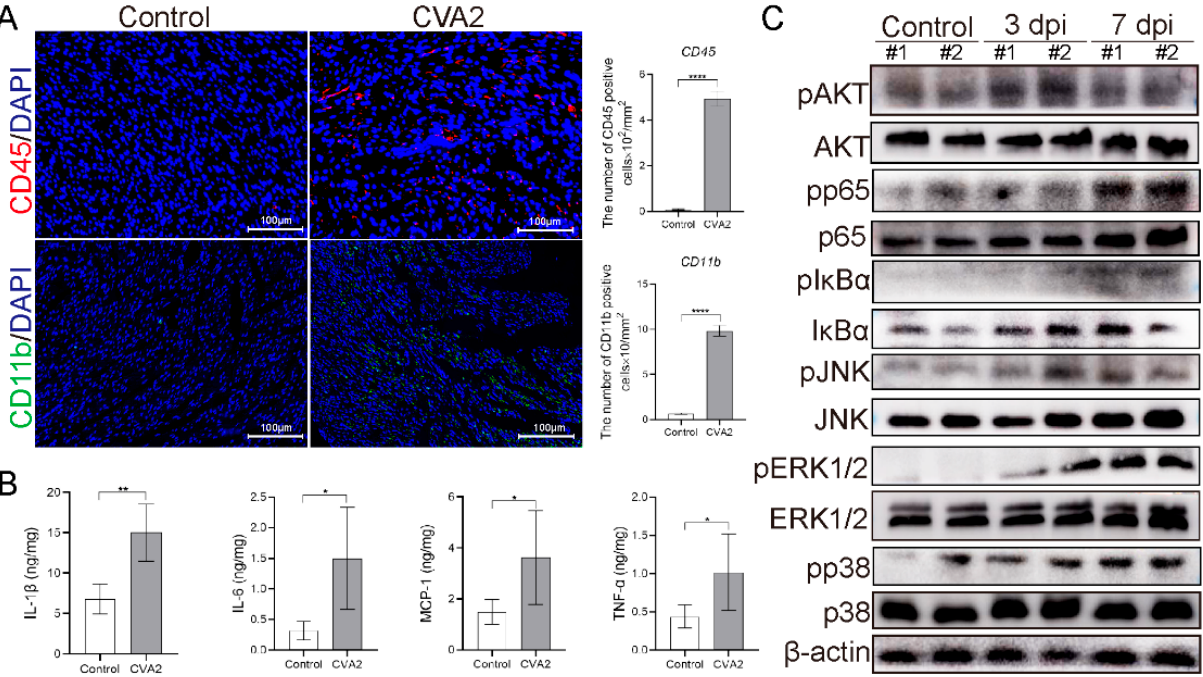
Figure 4. CVA2 infection induces excessive inflammatory responses in heart tissues. ( A ) Leukocyte infiltration in heart slices of control and infected mice. The numbers of CD45 or CD11b positive (CD45 + or CD11b + ) cells (per mm 2 heart tissues) were quantified by Image J soft-ware ( n = 4 per group). ( B ) The concentrations of cytokines (IL-1 β , IL-6, MCP-1 and TNF- α ) in the heart tissues of mice were determined using ELISA assay ( n = 4 per group). ( C ) Activation of inflammatory signal pathways (PI3K-AKT, MAPK and NF- κ B) was evaluated by Western blotting. * p < 0.05, ** p < 0. 01, **** p < 0.0001 vs. control.